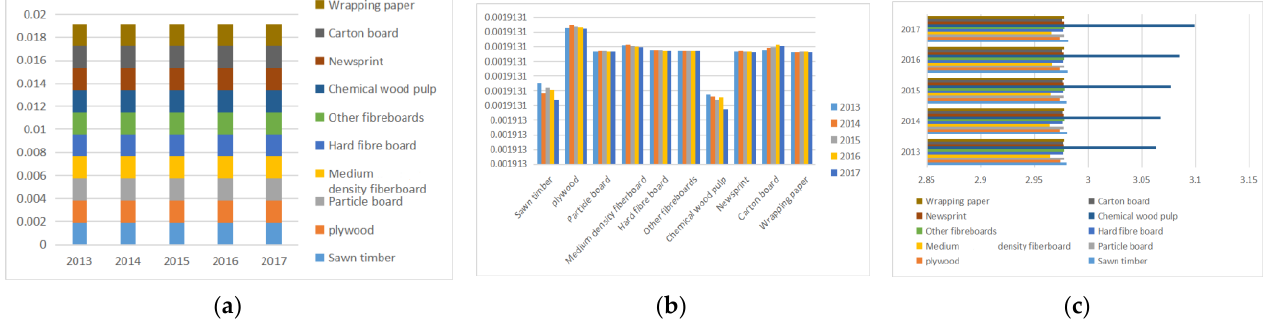
Figure 5. Pollution treatment at the level of green of China’s trade in wooden forest products and comprehensive score results of environmental trade competitiveness ( a ), pollution treatments ( b ), trade scale ( c ).